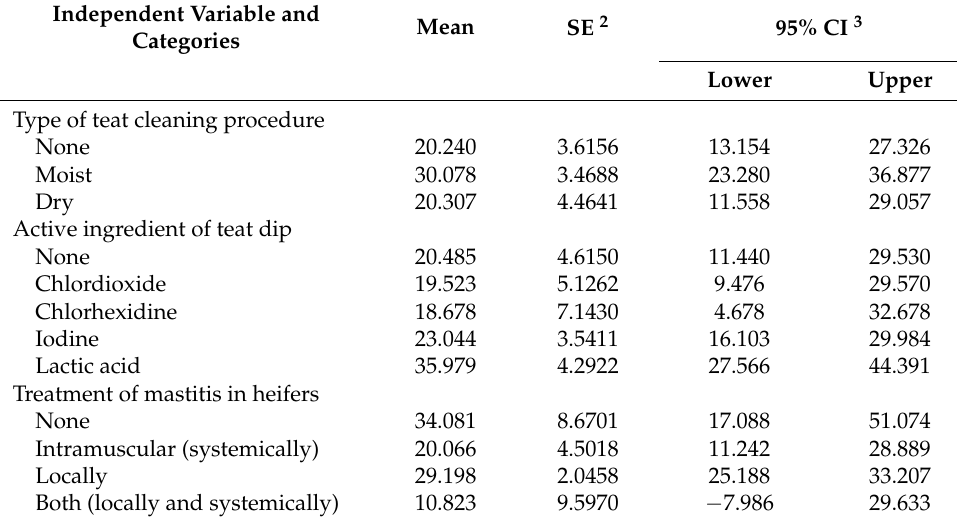
Table 7. Estimated marginal means describing the differences between categorical risk factor (inde- pendent variable) associated with HMR 1 (dependent